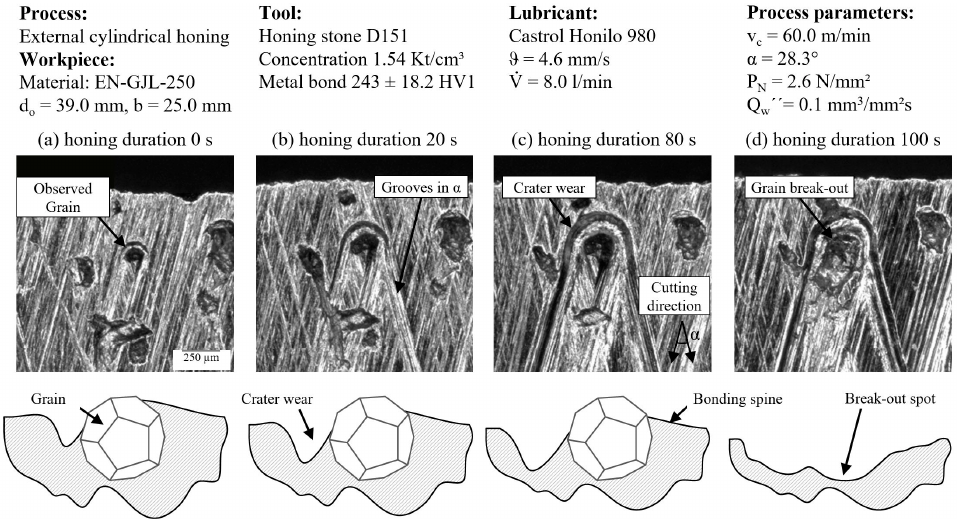
Figure 4. Progress of crater wear until grain break-out. (The experimental setup is as described in Chapter